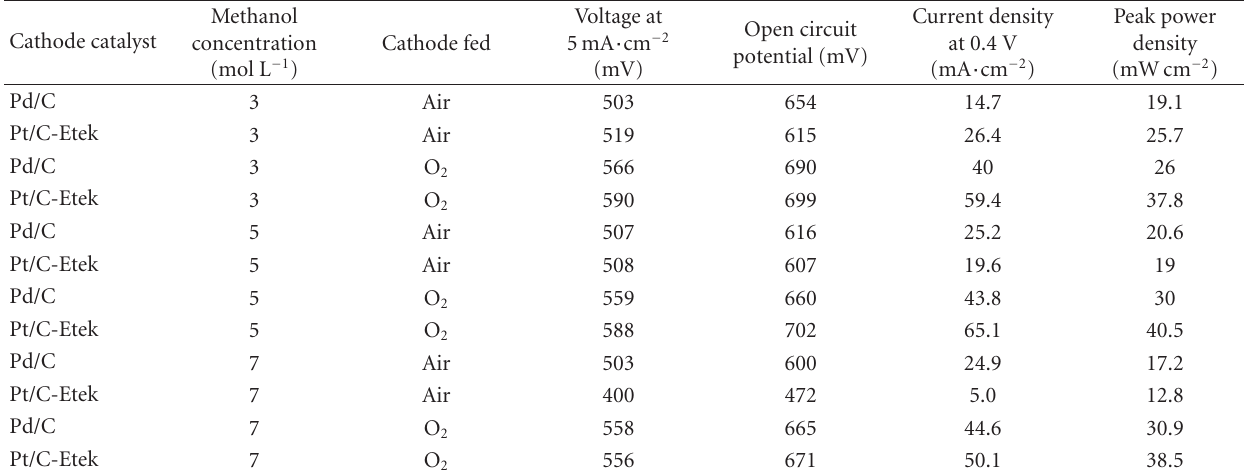
Table 5: Current densities at 0.4V, cell voltage at 5mA · cm − 2 , open circuit potential and peak power densities for a direct methanol fuel cell with 3, 5, and 7 M methanol solution fed to the anode at 60 ◦ C.